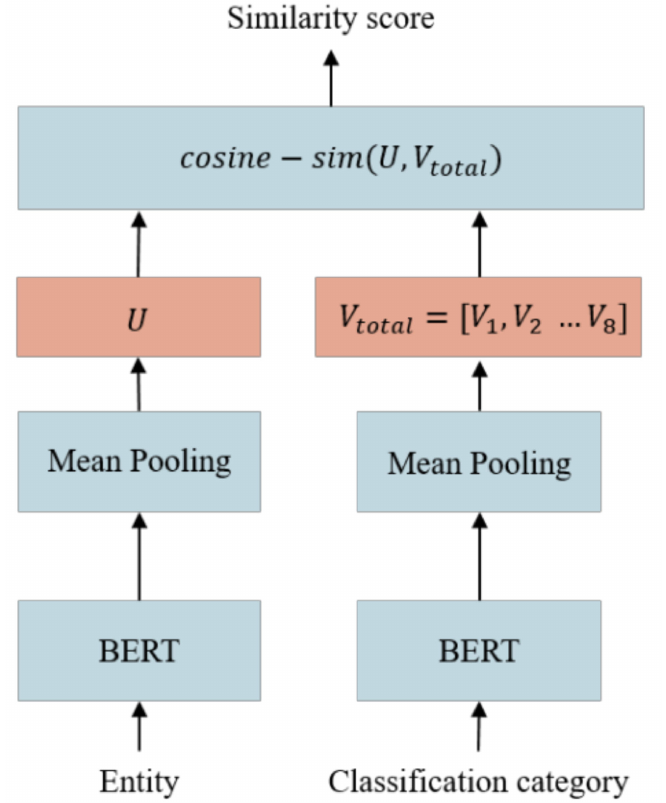
Figure 5. Architecture of the entity classification